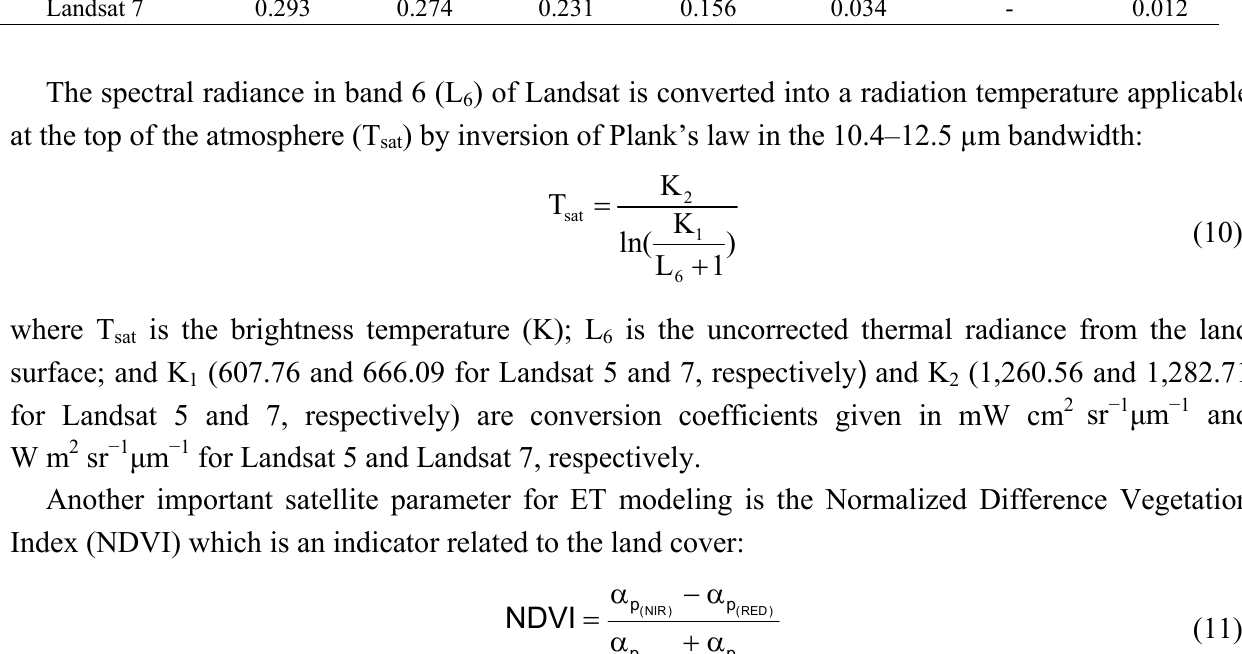
Table 2. Weighting coefficients (w